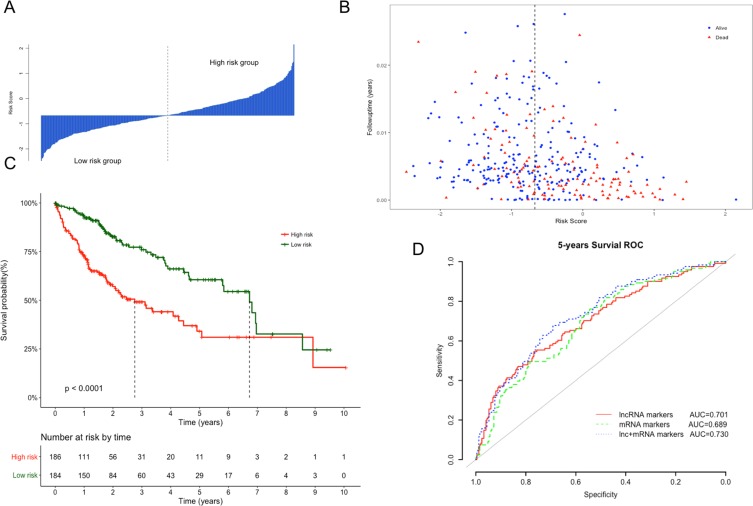
Performance evaluation of risk score model for overall survival prediction.(A) Bar plot of risk score for every patient and ordered by the value of risk score. (B) Distribution of following-up time and risk score for every patient. (C) Kaplan–Meier plots of overall survival for patients with high or low risk score. P value was calculated with two-sided log-rank test. (D) ROC curves of the risk score based on prognostic lncRNAs, mRNAs and combined transcripts for five-year survival prediction.